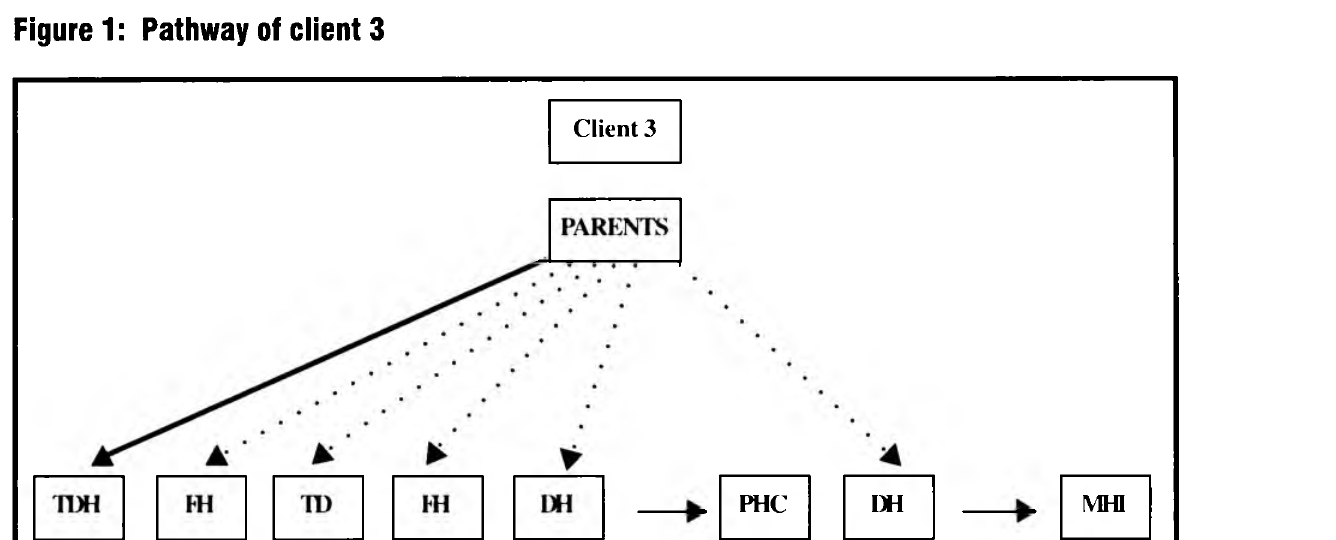
Figure 1: Pathway of client 3